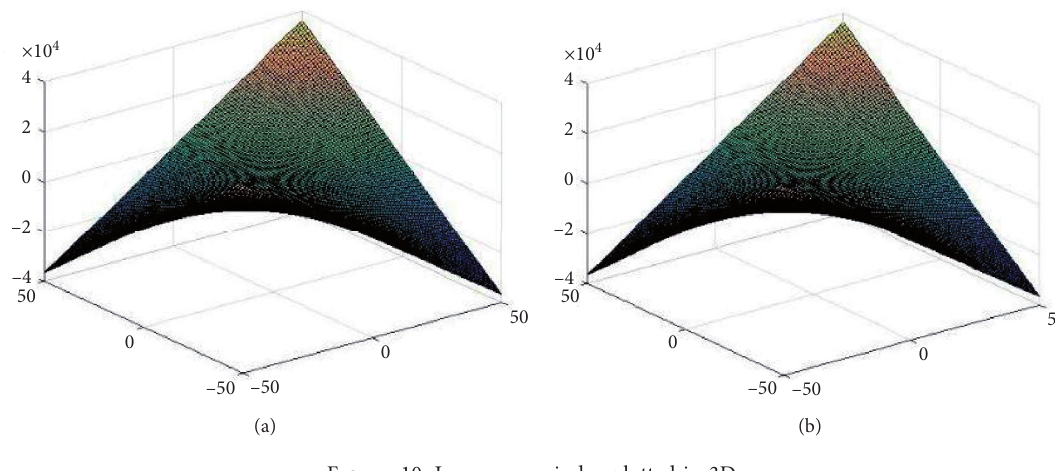
Figure 10: Inverse sum index plotted in